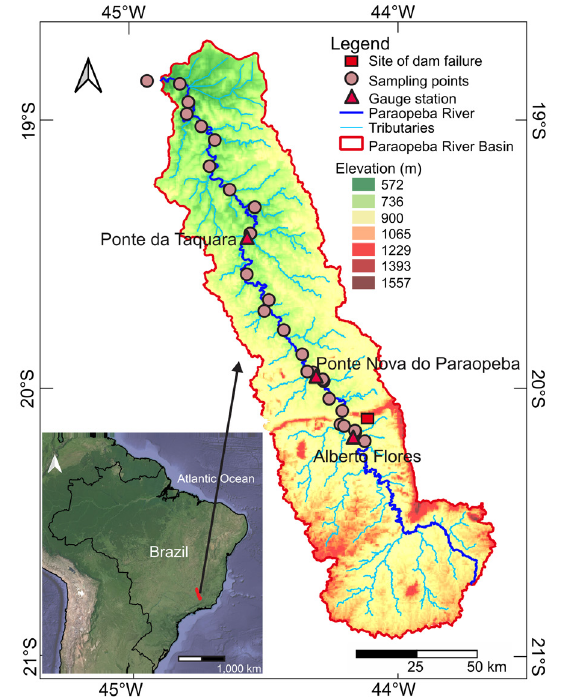
Figure 1. Location of the study area and distribution of the 49 in situ turbidity monitoring stations; site of the dam failure, and three gauge